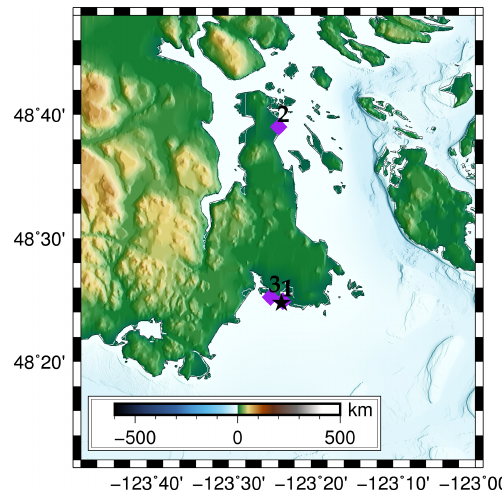
Figure 4. The location that drives the design algorithm is indicated with a black star (lat 48.4127, long − 123 . 3934). The locations of three emulators (01: lat 48.4149, long − 123 . 3904; 02: lat 48.6657, long − 123 . 3989; 03: lat 48.420584, long − 123 . 415478) at the cell centres of the grid are displayed with purple diamonds.